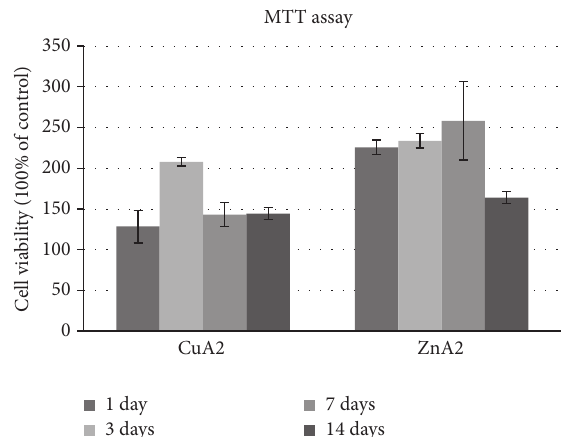
Figure 8: Evaluation of cell viability/proliferation of DPSCs seeded into the CuA2 and ZnA2 bioceramic scaffolds for 1, 3, 7, and 14 days (MTT